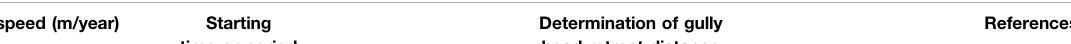
( Figure 2 ). The gully heads are only ~50 m apart in some locations, and they are tending to split the tableland into two parts, owing to the rapid erosion in the past few decades.